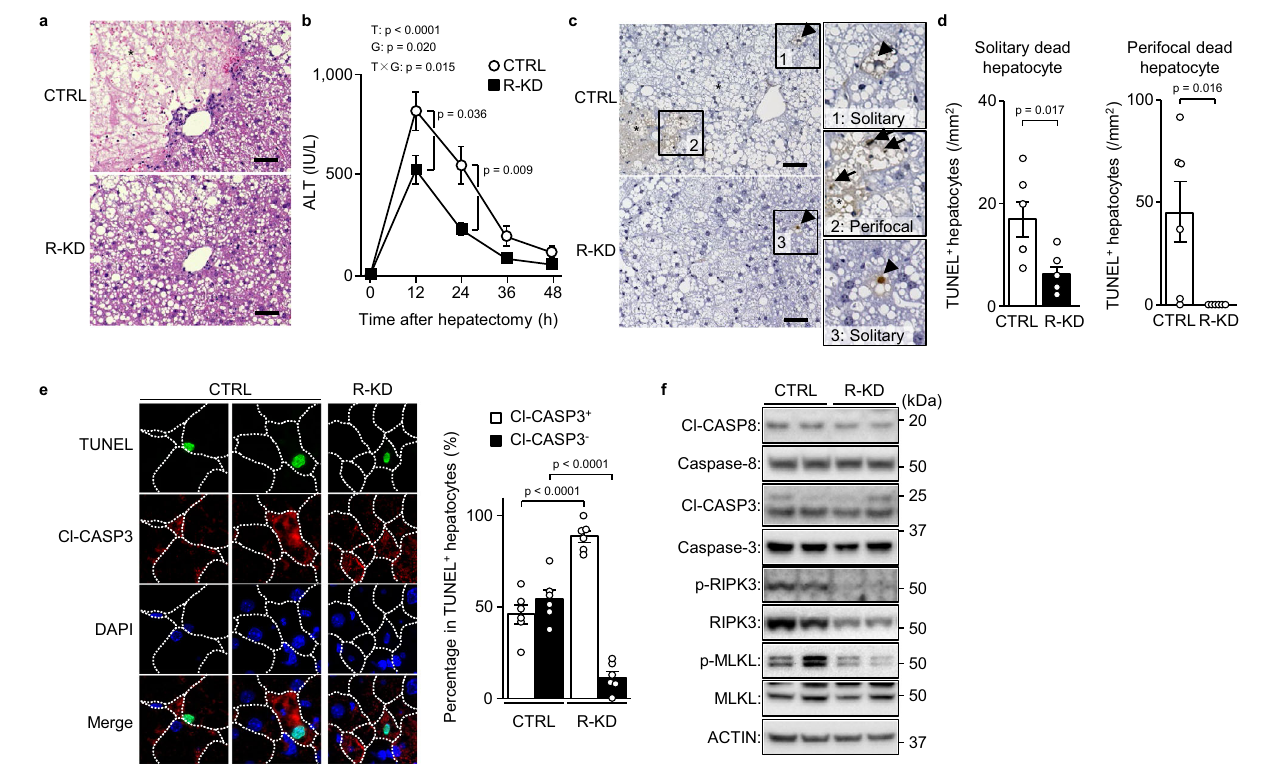
Fig. 2 | Non-apoptotic cell death by necroptosis in severe steatosis after hepatectomy. Mice fed a HFD for 16 weeks underwent Ripk3 knockdown (R-KD) andpartialhepatectomy. a Haematoxylin-eosinstaining.Scalebar,50 μ m.Asterisks indicatehepatocellulardeathfoci. b PlasmaALTlevels. c TUNELstaining.Scalebar, 50 μ m. Arrowheads indicate solitary dead hepatocytes. Asterisks indicate hepato- cellulardeathfoci.Arrowsindicateperifocaldeadhepatocytes. d NumberofTUNEL + hepatocytes de fi ned as described. e TUNEL/Cl-CASP3 double staining (left). Cl-